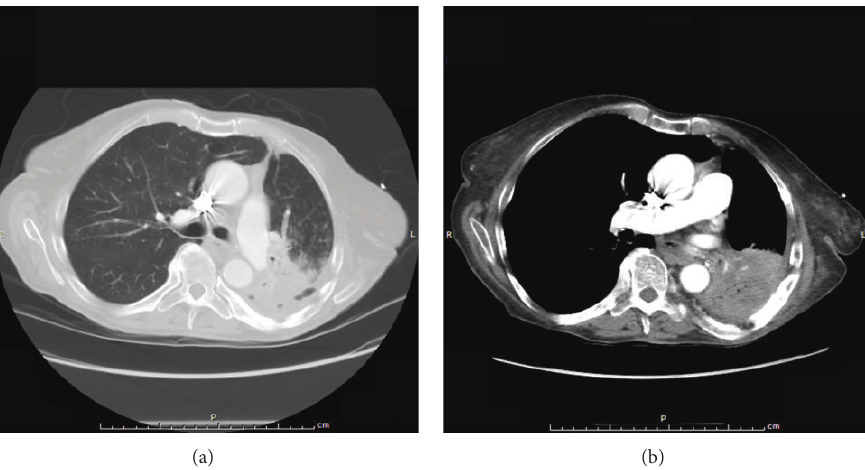
Figure 1: (a) Chest CT with “lung” windows shows an extensive dense lingular infiltrate with scattered air pockets; (b) chest CT with “soft tissue” cuts shows the same lingular infiltrate with extensive necrosis and scattered air